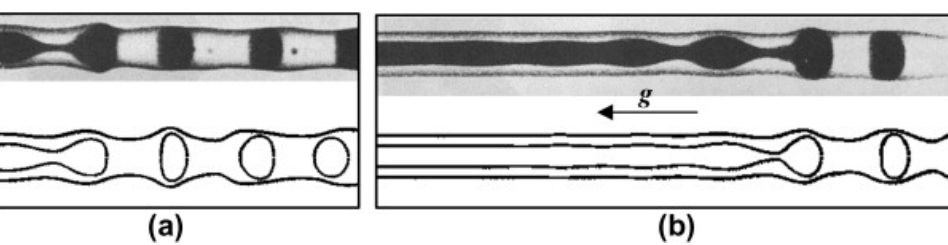
Figure 2. Grid refinement test for ρ 13 = 1, ρ 23 = 1, µ 13 = 1, µ 23 = 1 at non-dimensional times of: ( a ) τ = 0; ( b ) τ = 6.42 and ( c ) τ = 8.72, with the rest of the parameters as Re = 37.5 and We = 1.5.